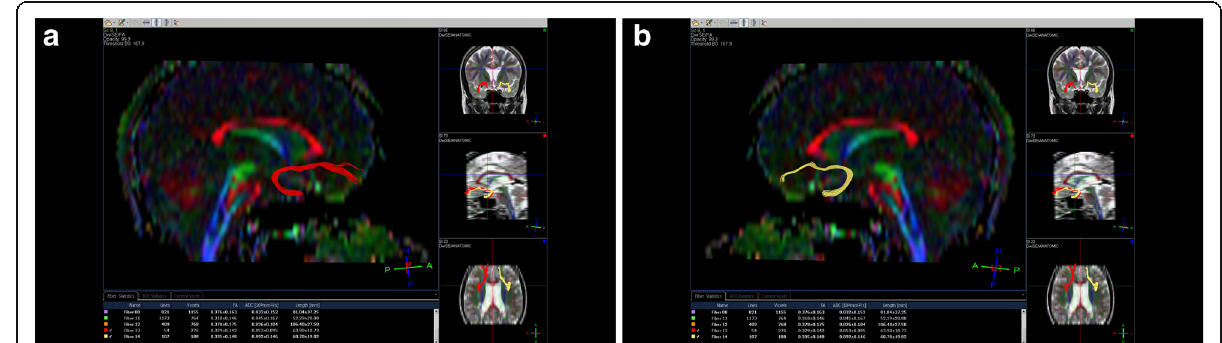
Fig. 2 26-year-old male patient known to have MS and presented with depression (BDI 18). Colour-coded FA maps with 3D fibre tractography of the uncinate fasiculi (UF). a Right side and b left side showing FA reduction of the right and left tracts (FA 0.329 ± 0.142 on the right and 0.335 ± 0.148 on the